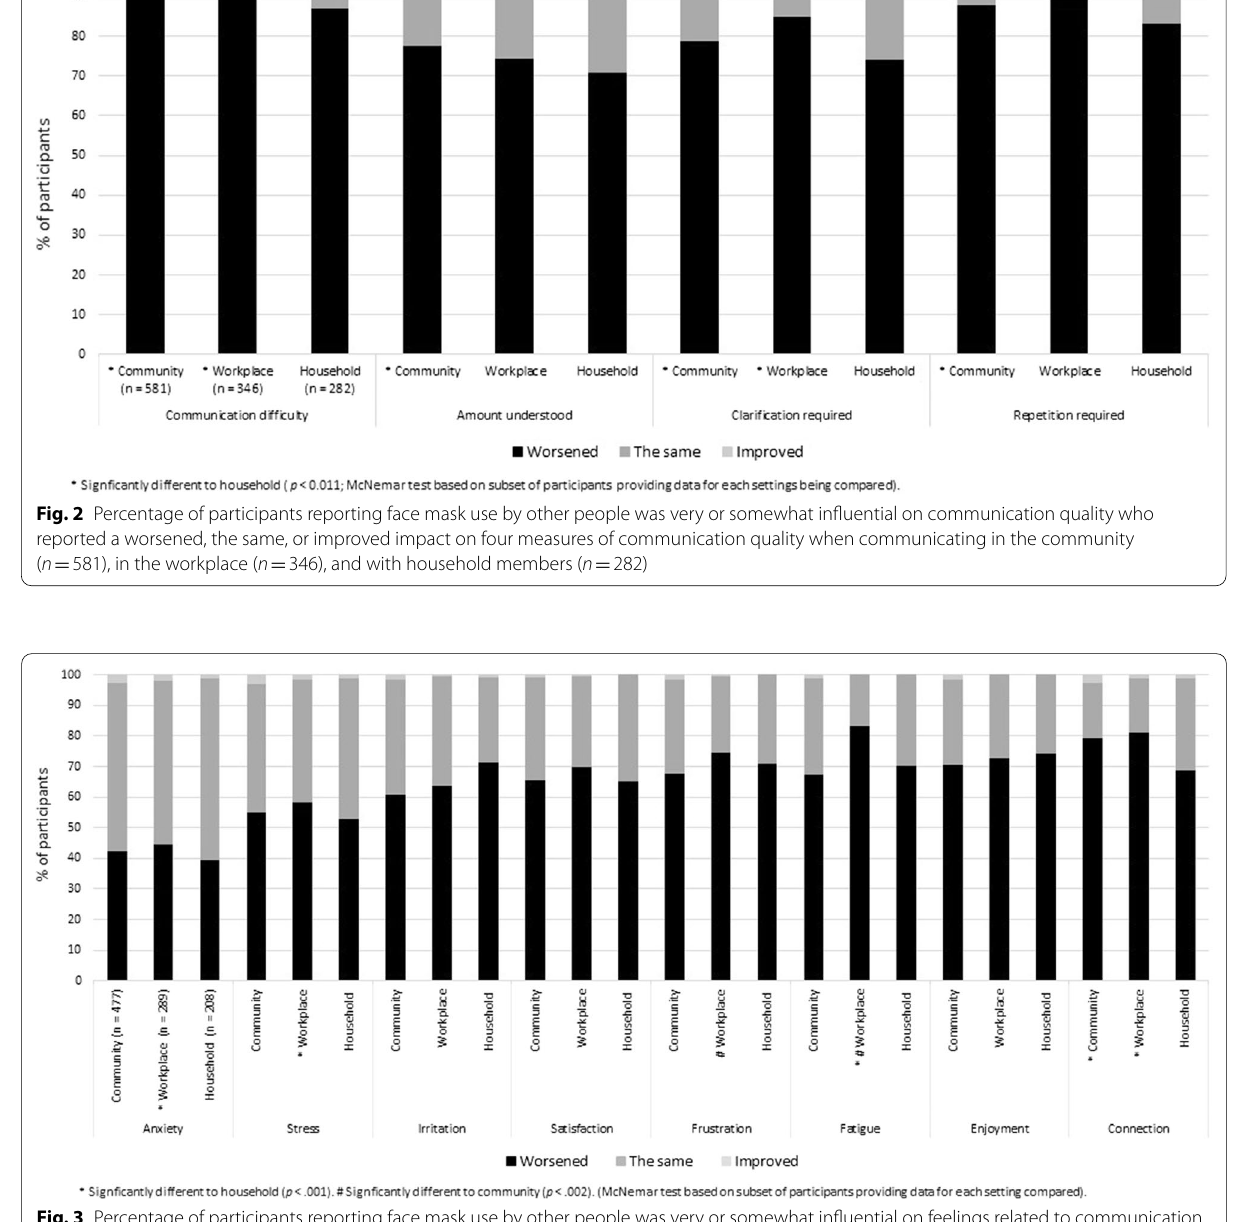
447), in the workplace =